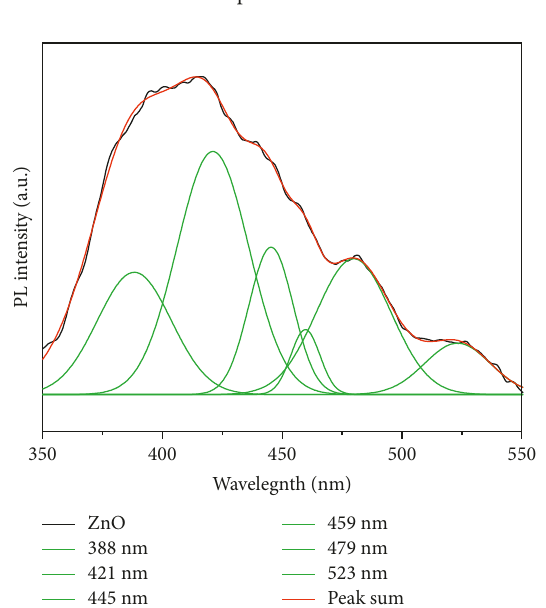
Figure 4: PL spectrum of SP-ZnONPs.